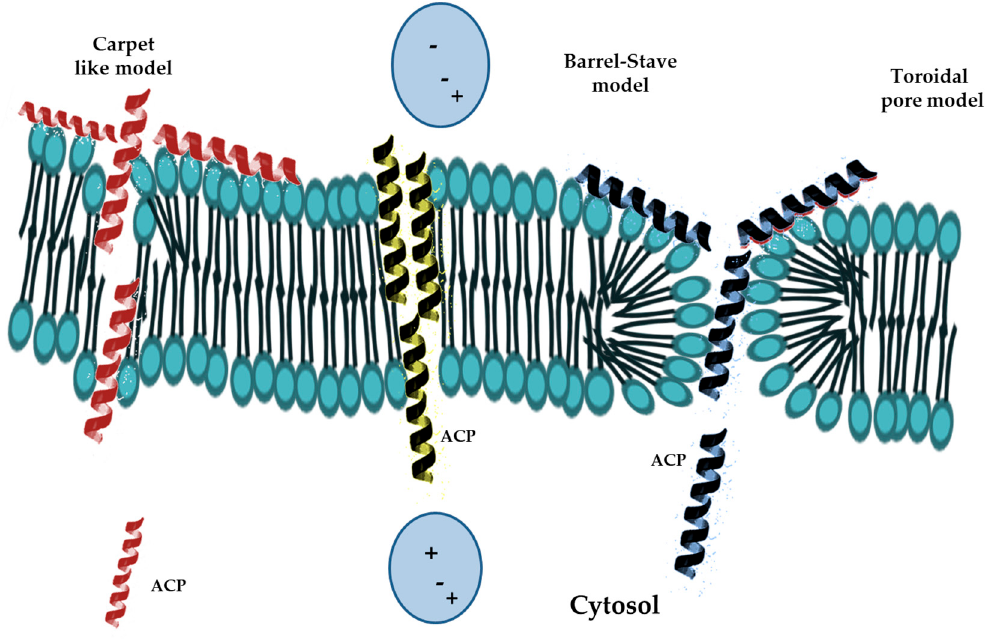
Figure 2. Schematic representation of most significant models of ACP’s action. From left to right: Carpet-like model, Barrel-stave model, Toroidal pore model.